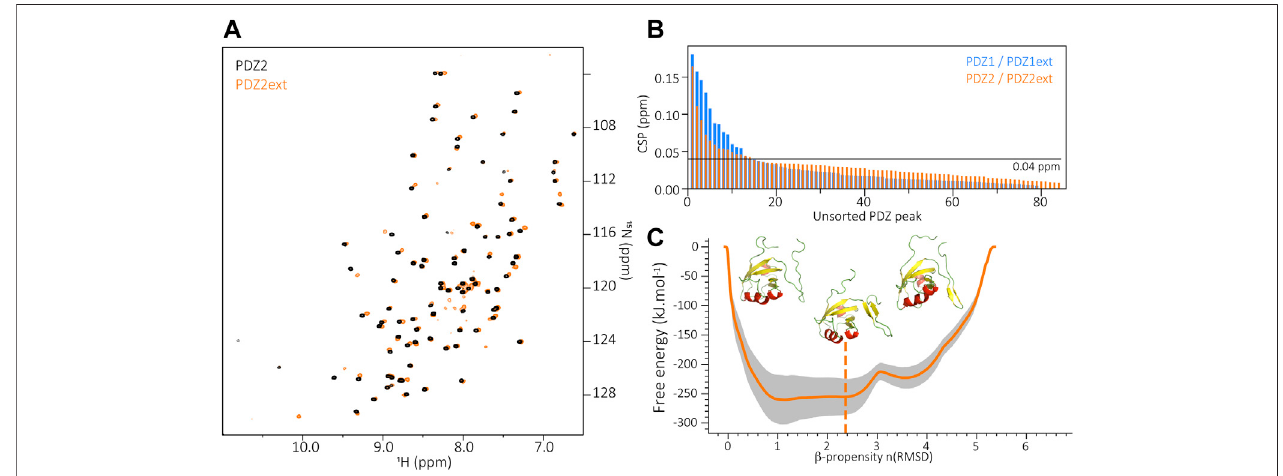
FIGURE3|(A) SuperimpositionofPDZ2(black)andPDZ2ext(orange) 1 H- 15 NHSQCspectra. (B) UnsortedChemicalShiftPerturbations(CSP)measuredforeach residue of the PDZ core when comparing PDZ1 to PDZ1ext (blue) and PDZ2 to PDZ2ext (orange). (C) Energy landscape obtained by metadynamics computing. The orange line indicates the average energy measured for each β propensity across four trajectories. Standard deviation is indicated by the grey outline. Displayed snapshots correspond to conformations extracted from the trajectory. The vertical dashed line indicates the starting point of the